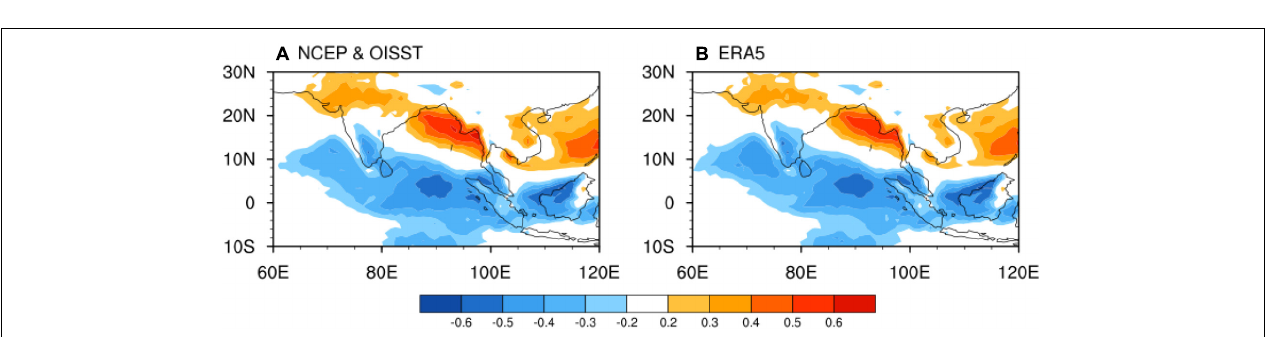
FIGURE 4 | The positive phase of the CIO mode calculated with (A) NCEP and OISST and (B) ERA5 during the period of 1998–2014. The reddish is for the positive SST anomaly and the bluish is for the negative SST mode anomaly ( ◦ C). Solid contours are for positive zonal winds (westerly winds; m/s) and the dashed contours are for negative zonal winds (easterly winds). (C) The CIO mode indices associated with (A) (black line) and (B) (red line).